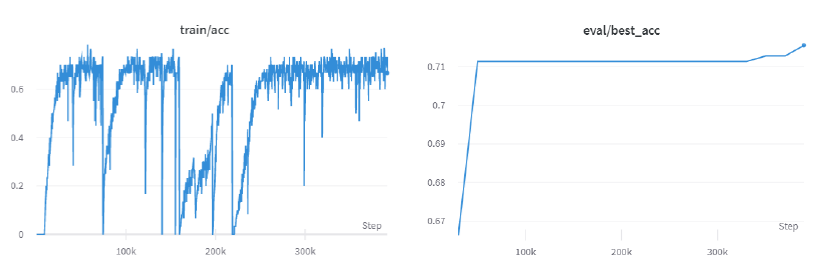
Figure 13. Best training and evaluation accuracy in ‘Experiment 9’.